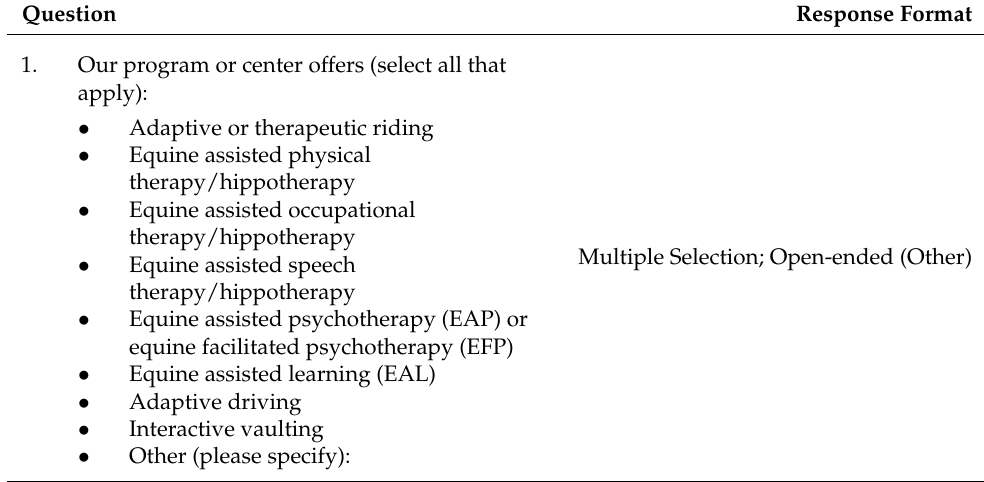
Table A2. Survey questions used in part II of the